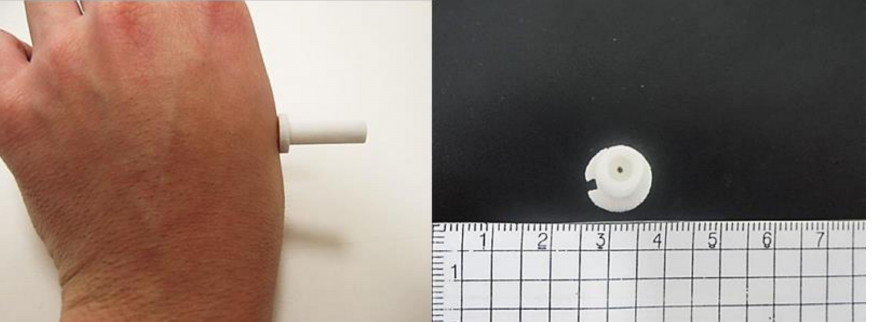
Figure 2. Inactive acupuncture guiding tube. Concaved needle handle anchor on the top with two insertion site markers on the side and adhesive button